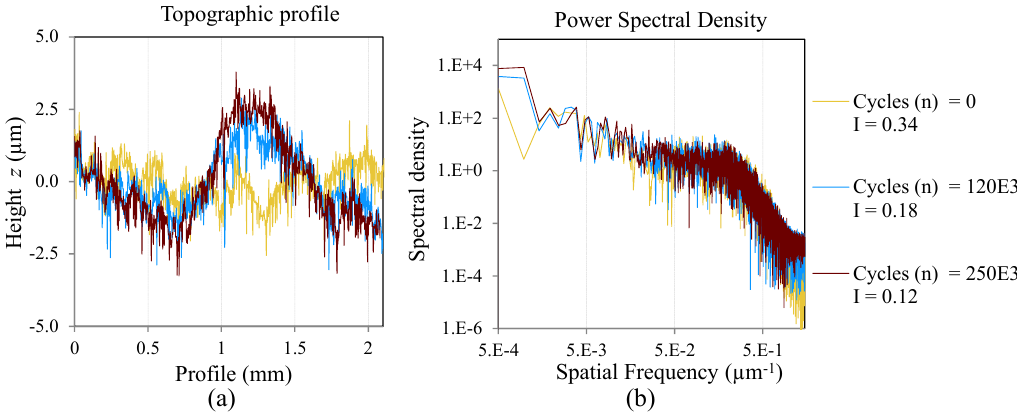
Figure 8. One area of inspection of the coupon C01 cycled at S max = 0.47 S ut ; ( a ) Topographic profile; ( b ) Power spectral density of the profile in log-log scale.